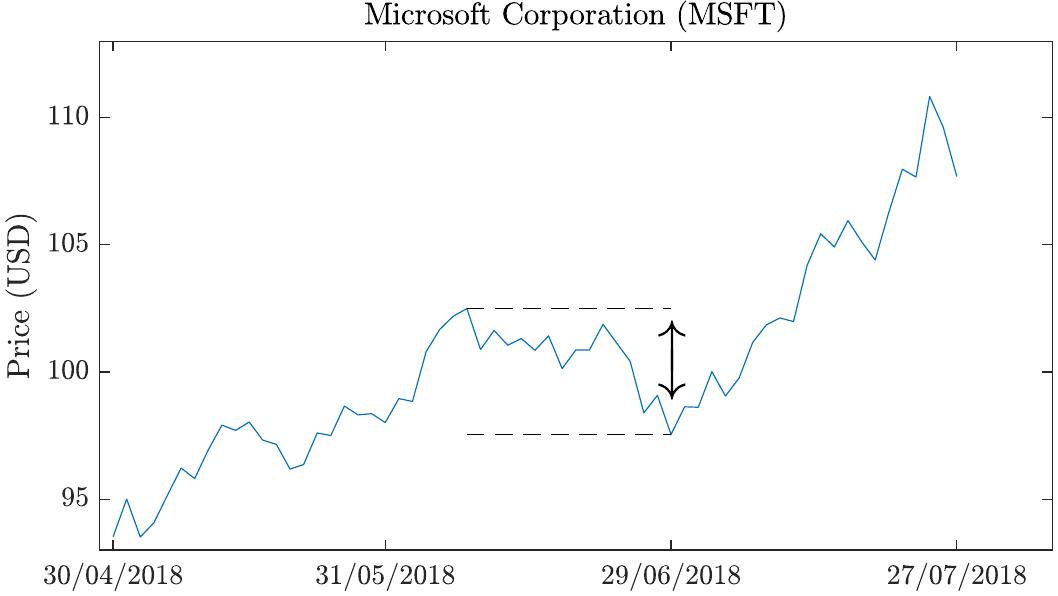
Figure 1. A sample drawdown for the Microsoft Corporation stock is marked with black arrows and dashed lines. Data is taken from